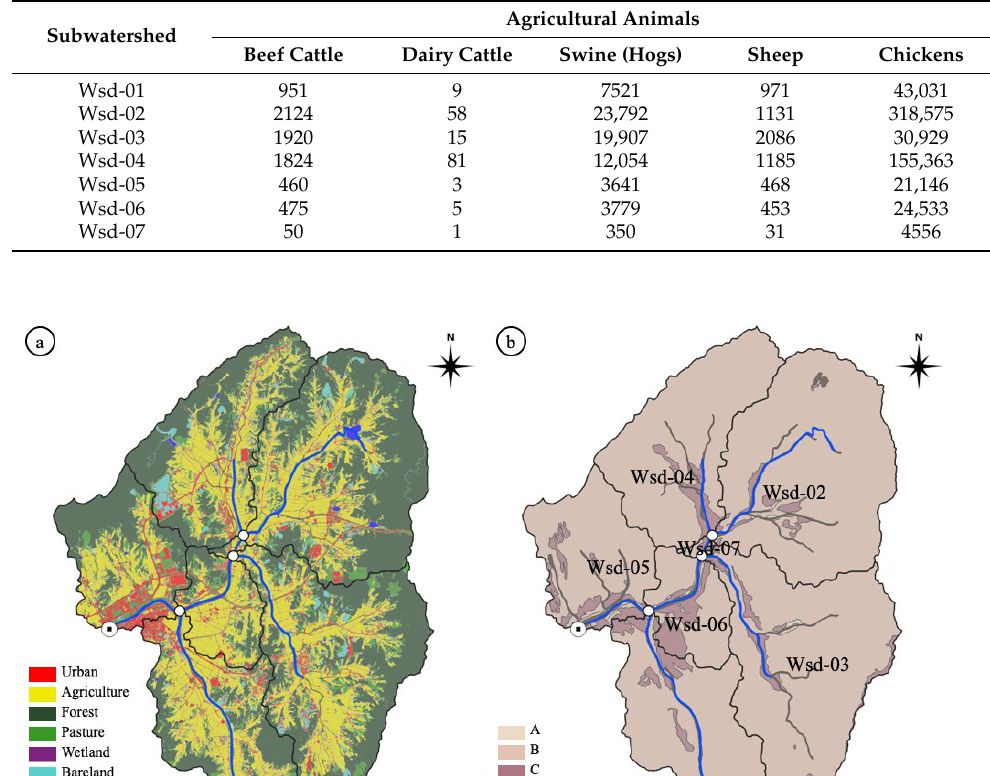
Table 2. Number of agricultural animals in subwatersheds where model was